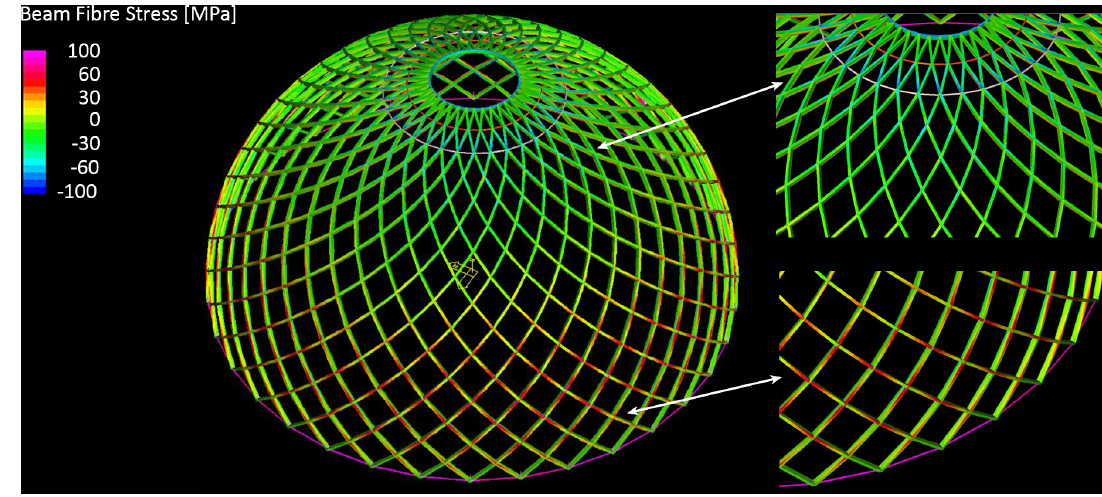
Figure 17: Left: Stresses due to axial forces and bending moments (fibre stresses) in the reciprocal frame beams. Top right: detail of ele- ment stresses in the upper part. Bottom right: detail of element stresses in the lower part